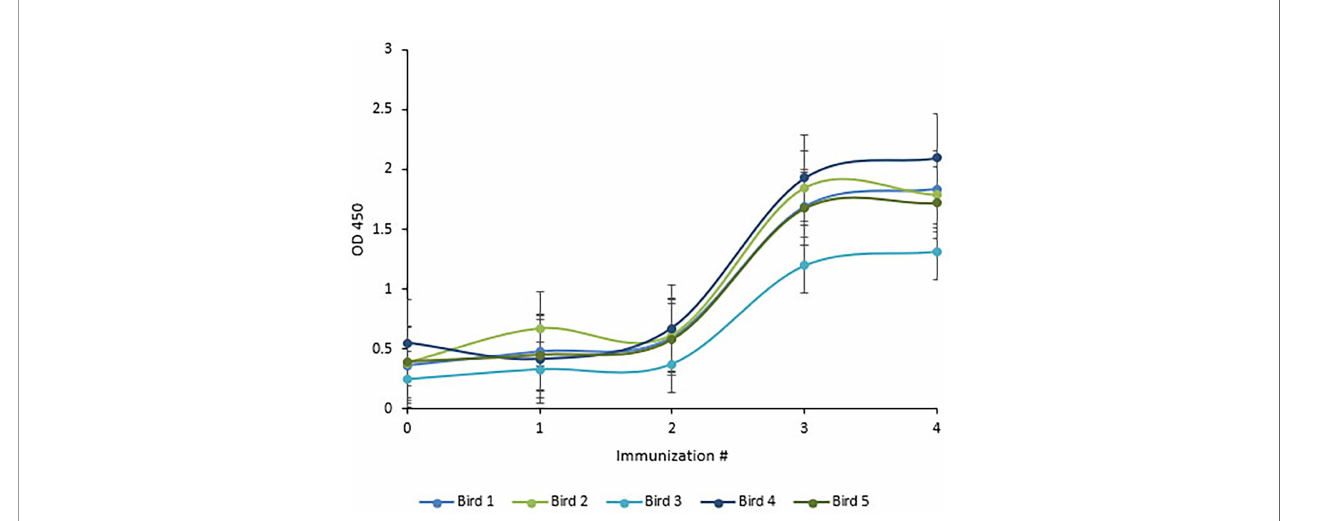
FIGURE 5 | Chickens reached maximal anti-HRV titers after three immunizations. ELISA quanti fi cation of chicken anti-HRV speci fi c serum antibody level in response to immunization. An ELISA plate was coated with 10µg/ml of puri fi ed HRV and blocked with 2% BSA in PBS. Pre- and hyper-immune serum antibodies served as the primary antibody (1:1000). HRP-conjugated goat anti-chicken IgY served as the secondary antibody (1:3,000). Titers peaked after the third immunization and birds were considered to be hyperimmunized.